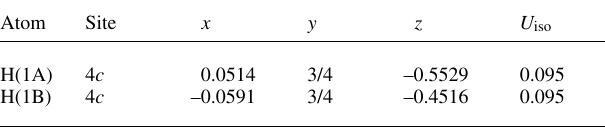
Table 2. Atomic coordinates and displacement parameters (in Å 2 )